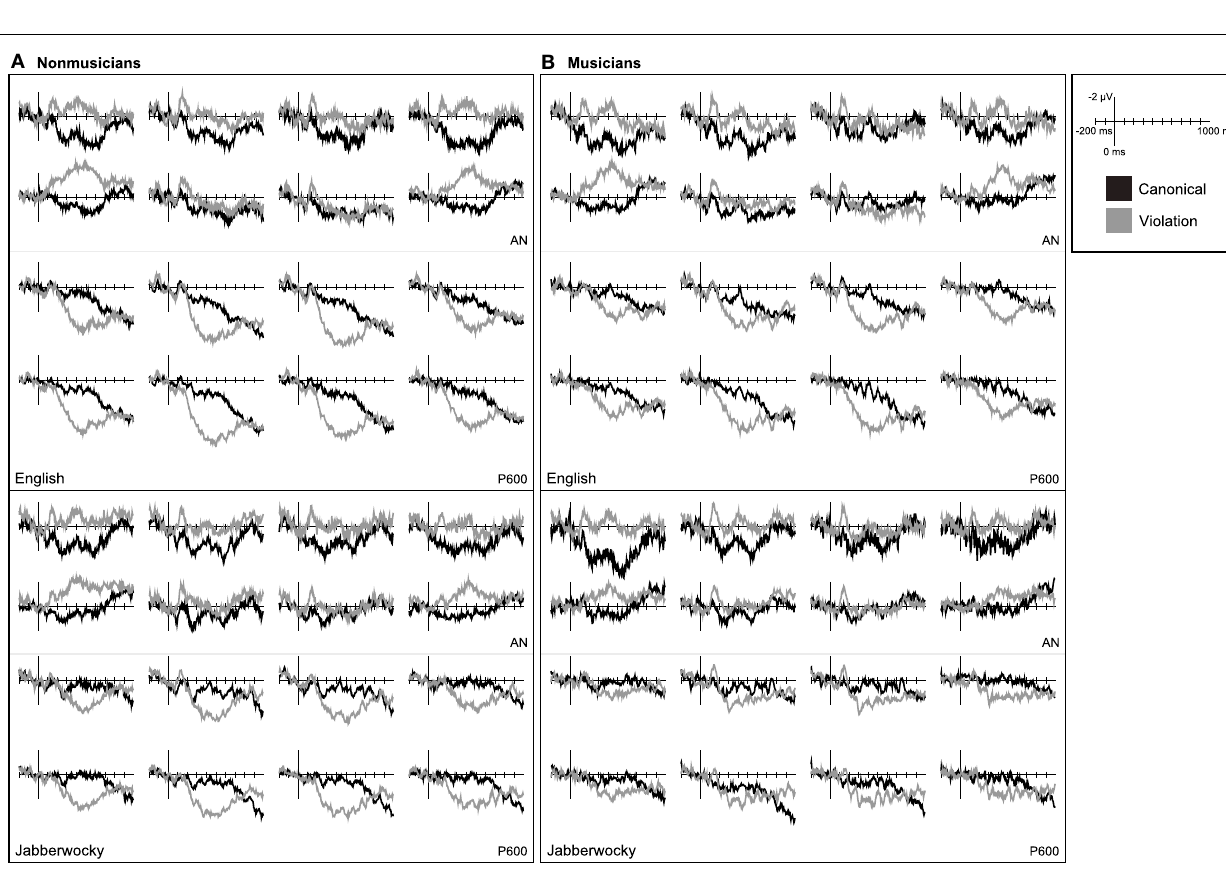
interaction, F (2, 38) = 34.49, p < 0.001, indicated that the AN was larger over more anterior regions [most anterior row CV: F (1, 19) = 17.84, p < 0.001; second-most anterior row CV: F (1, 19) = 11.70, p = 0.003; two anterior-most rows CV: F (1, 19) = 15.54, p = 0.001]. The late AN 300–500 ms after onset